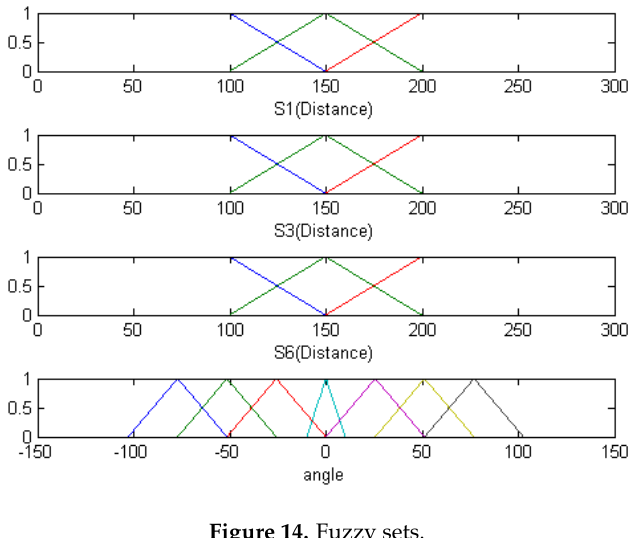
Figure 14. Fuzzy sets. Figure 14. Fuzzy